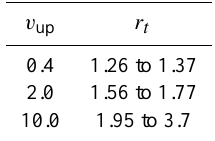
Table 2. Values of the ratio r t = N tdfr of the updraft, v up